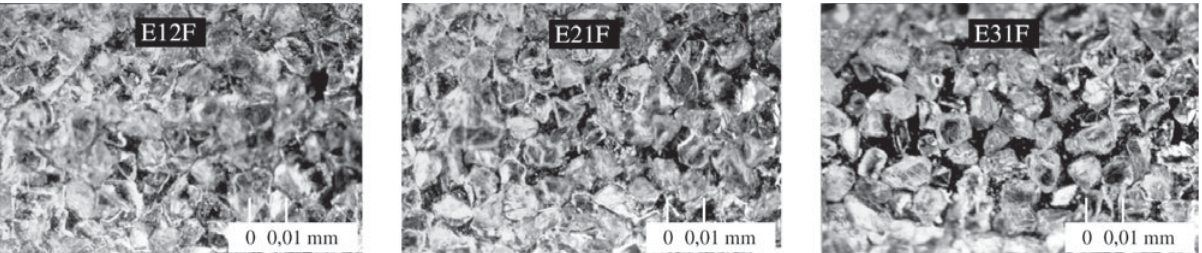
Figura 5. Superfície da ponta usinada após a realização dos ensaios, após uma, duas e três esterilizações em estufa, respectivamente.